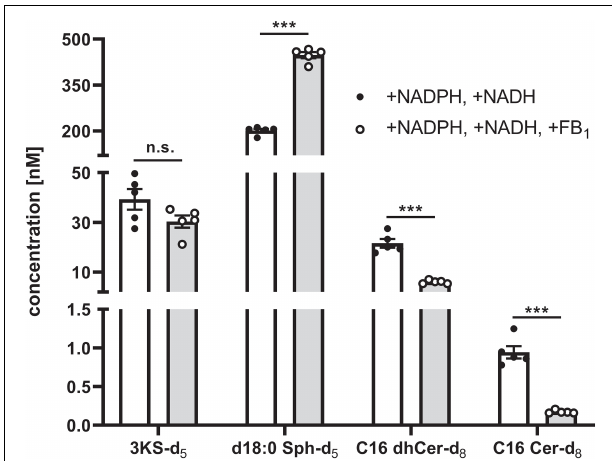
FIGURE 8 | Intra-assay variability of the sphingolipid de novo synthesis assay. A total of 10 technical assay replicates were prepared, five of which were supplemented with NADPH and NADH (white bars and solid circles), while the remaining five replicates were additionally with fumonisin B 1 (FB 1 , gray bars and open circles). Assays were performed as described in the Materials and Methods section using identical batches of microsomes and reagents. Concentrations of de novo formed, deuterated sphingolipid metabolites in the final sample volume (100 µ L) were quantified by HPLC-MS/MS using external calibration (concentration range: 0–1000 nM). To this end, 3KS-d 5 and d18:0 Sph-d 5 were quantified via d18:0 Sph, whereas calibration curves of Cer d18:0/16:0 and Cer d18:1/16:0 were used to quantify Cer d18:0-d 5 /16:0-d 3 (C16 dhCer-d 8 ) and Cer d18:1-d 5 /16:0-d 3 (C16 Cer-d 8 ), respectively. Cer d18:1/17:0 and d17:0 Sph were used as internal standards. Bars represent mean concentrations (detailed in the main text) ± SEM ( ∗∗∗ p < 0.001; n.s., non-significant; n = 5). Additionally, individual values of the replicates are depicted as